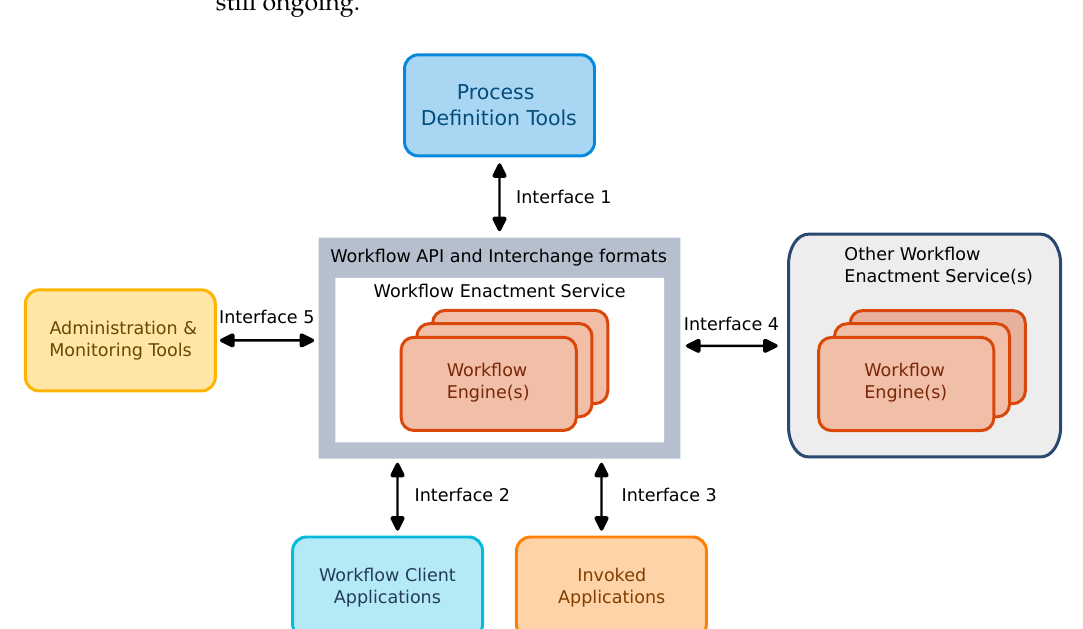
Figure 2. The workflow reference model, adapted from [11]